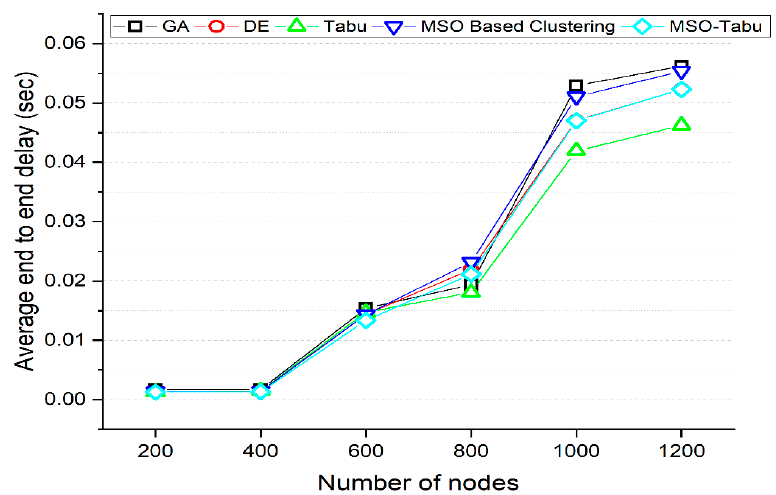
Figure 2. Average End to End Delay for MSO-Tabu.